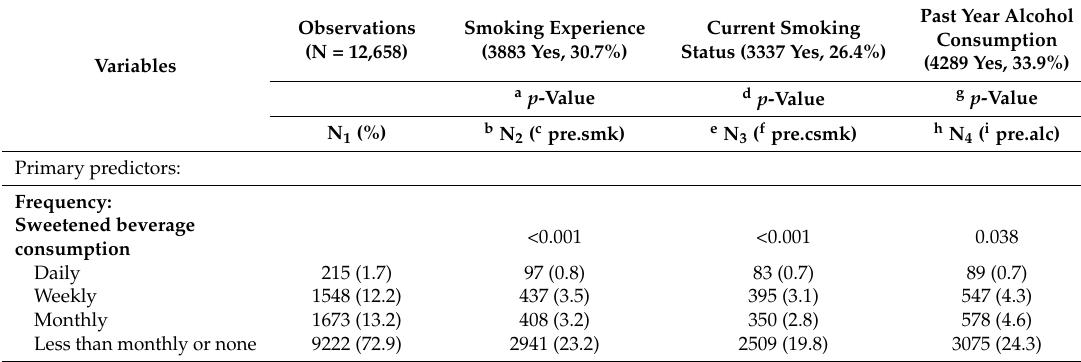
Table 1. Descriptive statistics, prevalence rates by variables, and crude examinations for the study sample (N = 12,658). Data source: Chinese Health and Nutrition Survey,